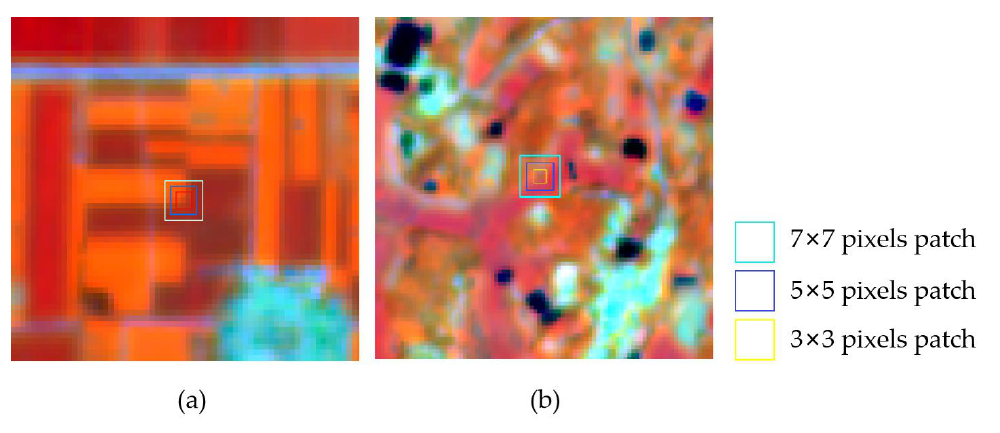
Figure 1. Coverage of different patch sizes in complex scenarios. ( a ) Mixed planting scenario, where crops grow in a random pattern. There are multiple crops in a small area. ( b ) Mountain terrace scenario, where crops grow in valleys with smaller